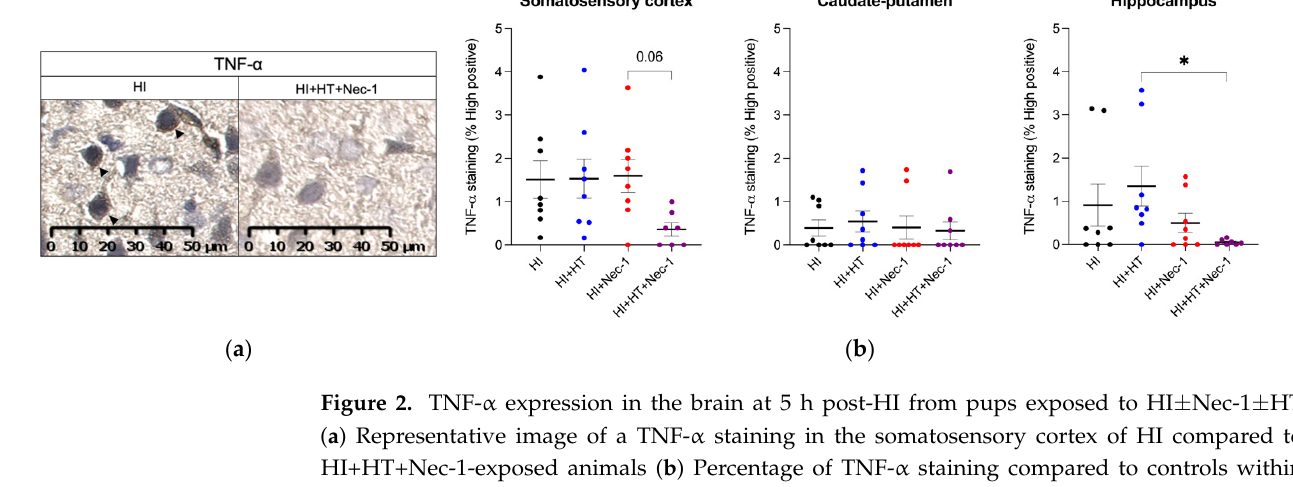
Figure 2. TNF- α expression in the brain at 5 h post-HI from pups exposed to HI±Nec-1±HT. ( a ) Representative image of a TNF- α staining in the somatosensory cortex of HI compared to HI+HT+Nec-1-exposed animals ( b ) Percentage of TNF- α staining compared to controls within the somatosensory cortex, caudate-putamen, and hippocampus in HI±Nec-1±HT conditions. The number (n) of rats used was n = 7–8 per conditions from 8 litters. The bars indicate the mean ± SEM. * p ≤ 0.05, Kruskal–Wallis with Dunn’s multiple comparisons tests. Abbreviations: CTL: control; HI: hypoxia-ischemia, HT: hypothermia; Nec-1: necrostatin-1; TNF- α : tumor necrosis factor- α .